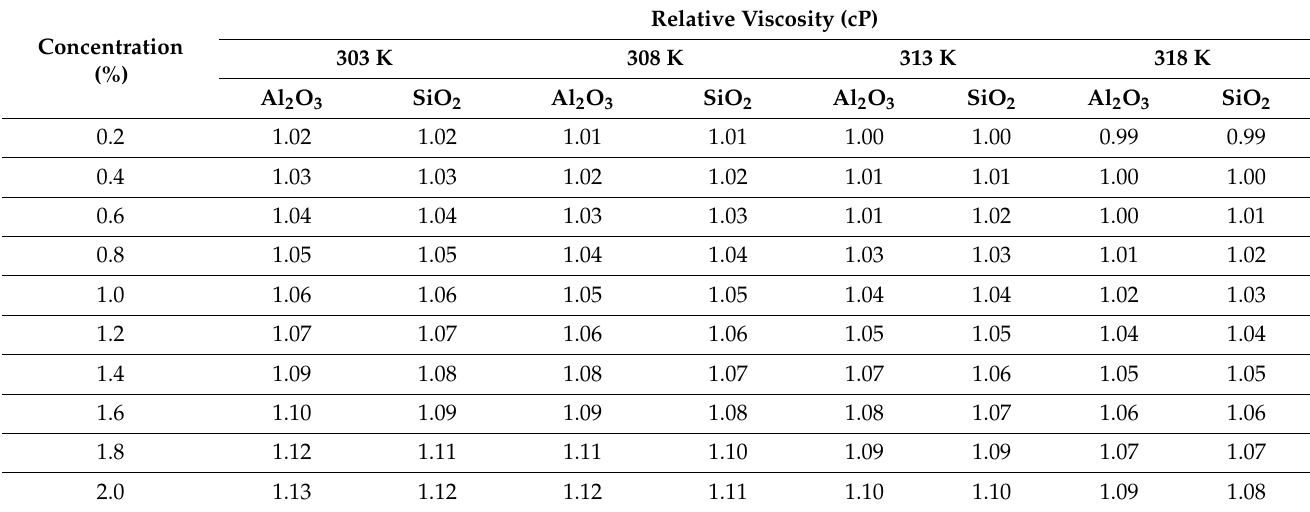
Table 1. Table 1. The relative viscosity of Al 2 O 3 and SiO 2